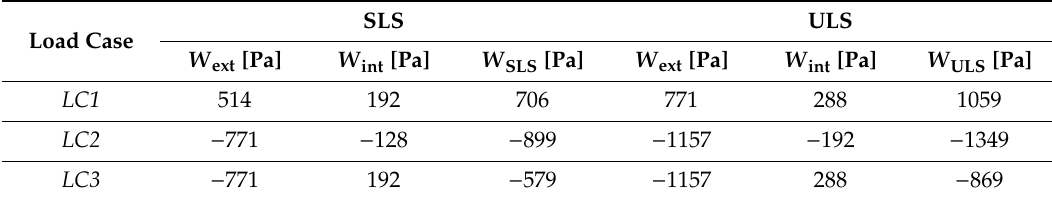
Table 3. Three wind load cases applied to sandwich